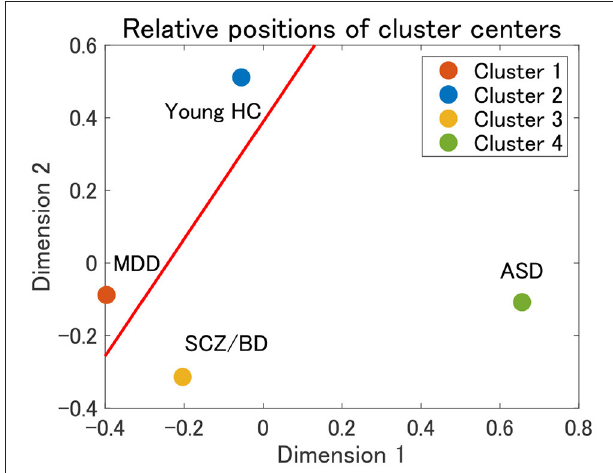
FIGURE 9 | Relative positions of cluster centers in view 4 by means of multidimensional scaling (MDS). The red line denotes a possible axis for the continuum of clusters 1–3, which is a linear regression line for the centers of clusters 1–3.